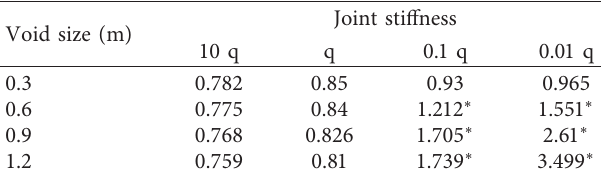
Figure 12: Tensile stress of the loaded slab with joint stiffness of 10q and void size of 1.2 m (slab top). Table 2: The location of the stress under different